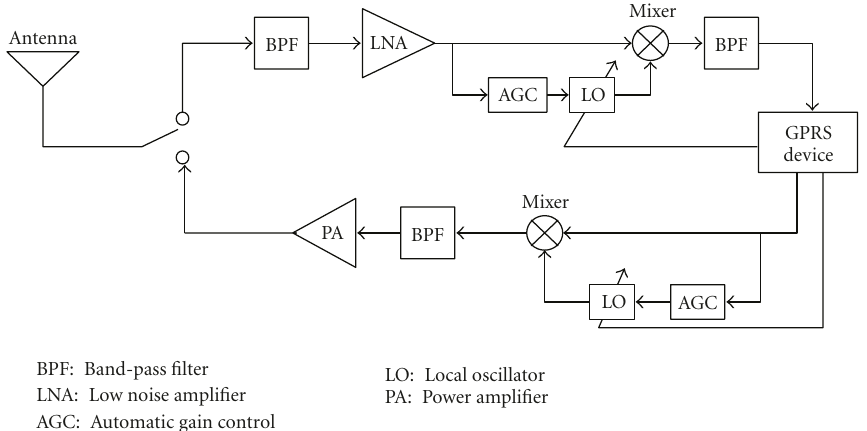
Figure 4: A GPRS mobile station with up/down converters. Note that the Local Oscillators (LOs) can be either manually adjusted or controlled by the GPRS mobile station.